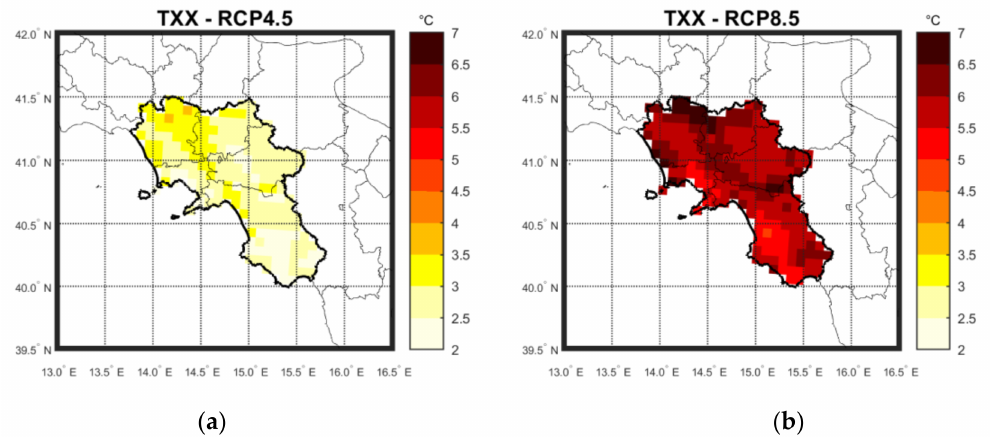
Figure 7. Maps of the difference of the average TXx value projected over the future period 2071–2100, with respect to the past period 1981–2010 under ( a ) RCP4.5 and ( b ) RCP8.5.